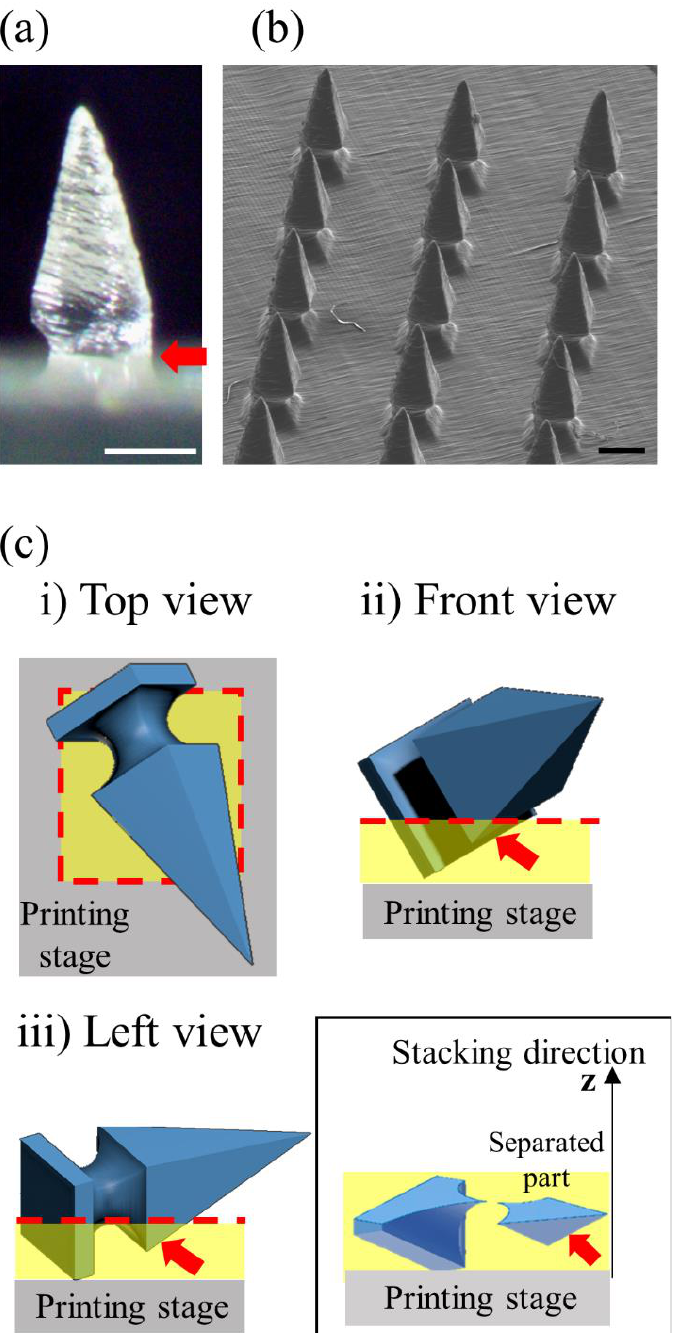
Figure 8. Fabrication of high-dimensional side-notched arrowhead (SNA) microneedles by optimized 3D printing. The SNA microneedles were measured using a stereomicroscope ( a ) and SEM ( b ) (All scale bars are 0.5 mm). ( c ) The 3D design of the SNA microneedles rotated to 60° printing angle for both x and y axes with ( i ) top, ( ii ) front, and ( iii ) left views. A separated part (red arrow) from the microneedle body was generated in the single stacking layer indicated by the red dotted line due to the specificity of the SNA microneedle structure (inset). The separated part was 3D printed inaccurately.